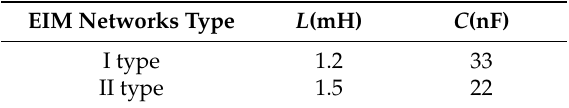
f s = 24.363 kHz by AC analysis and the detailed parameters of EIM networks are listed in Table 5. Table 5. The parameters of EIM networks for the pitch-catch setup. Table 5. The parameters of EIM networks for the pitch-catch